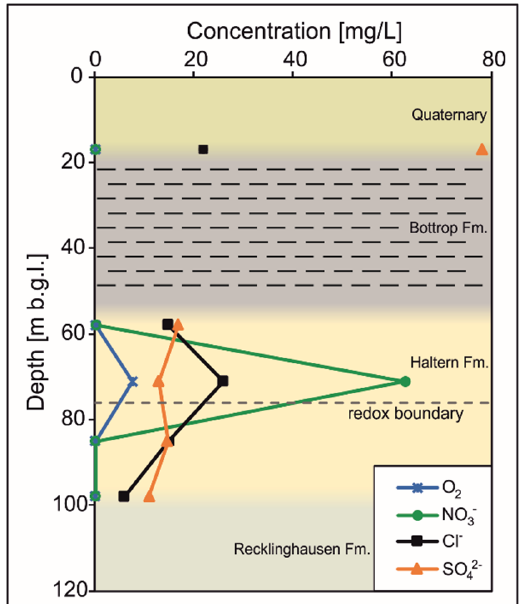
Figure 9. Concentration of selected anions as well as O 2 in the groundwater of the Haltern Fm.